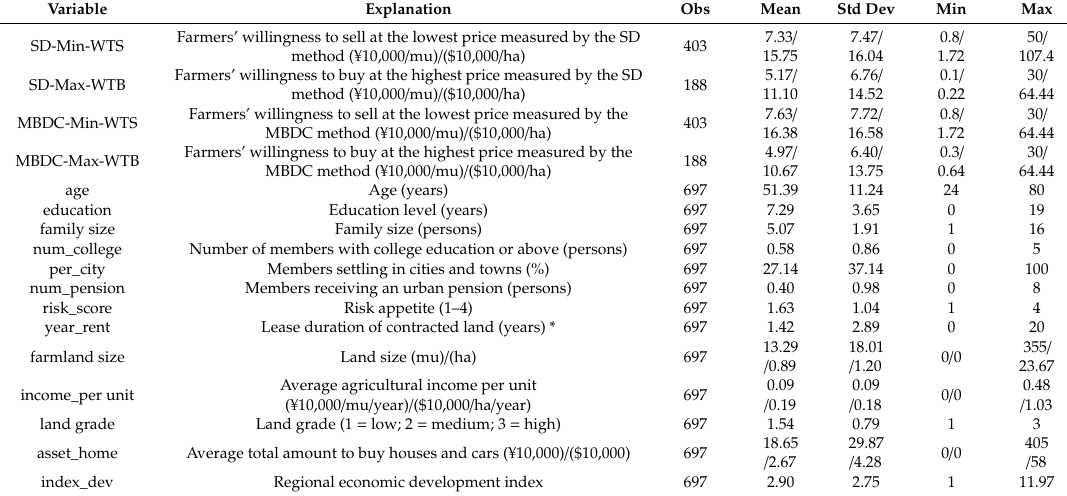
Table 3. Definitions and statistical descriptions of main variables. SD, self-declared; WTS, willingness to sell; WTB, willingness to buy; MBDC, multiple bounded discrete